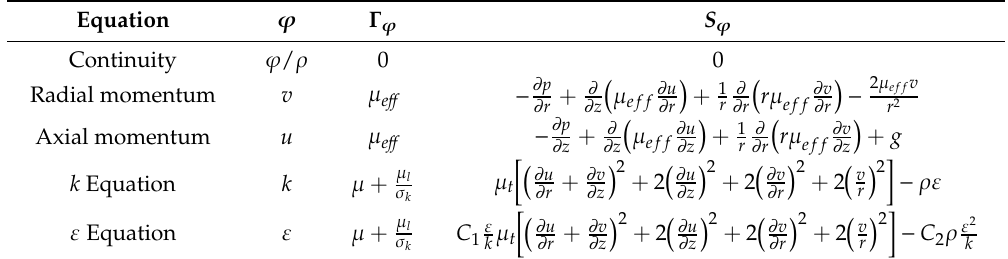
Table 1. Source terms and values of coe ffi cients of Generic Transport Equations